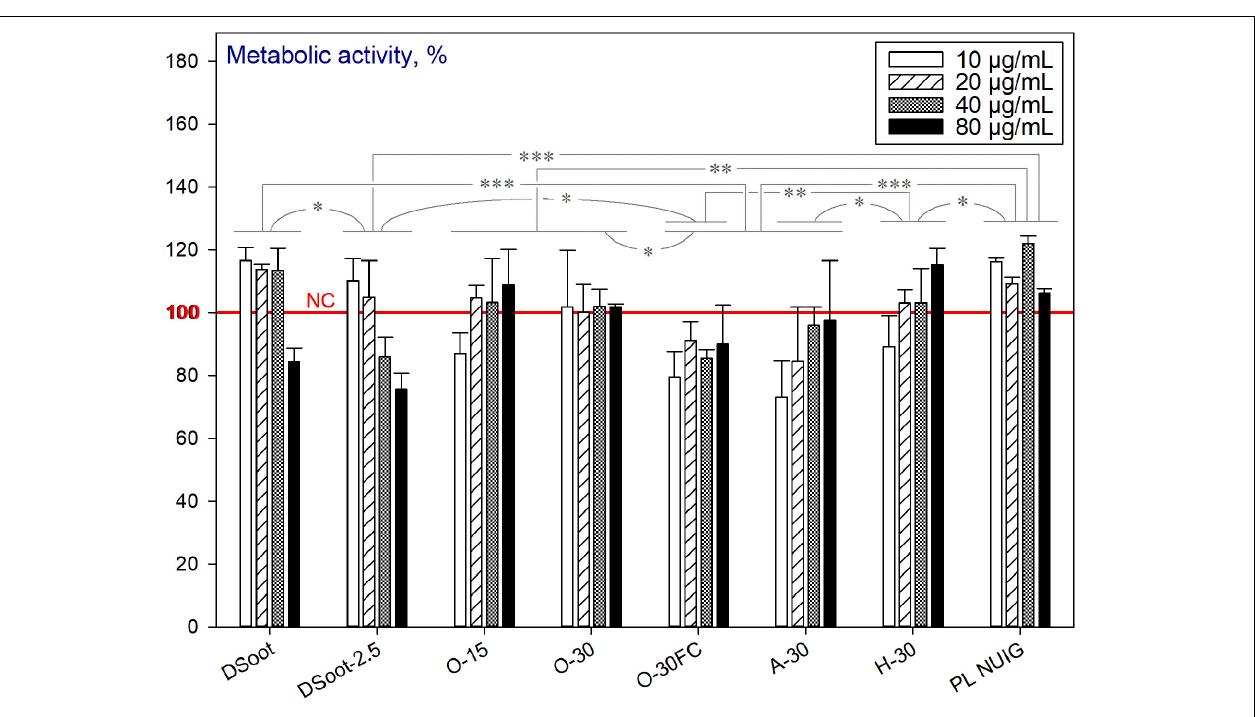
Frontiers in Bioengineering and Biotechnology |